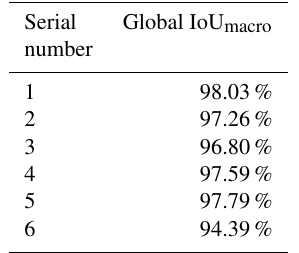
Table 3. Global IoU macro scores of the DL-based semantic segmen- tation